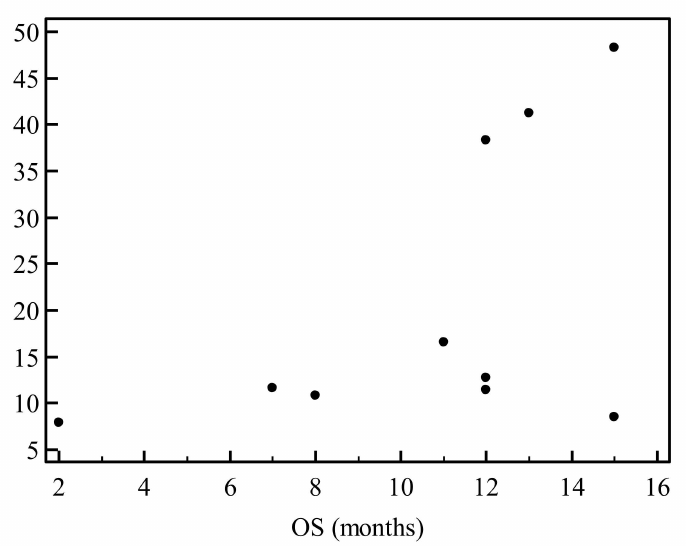
Figure 5. GATA6 / ZEB1 ratio shows a trend towards a correlation with overall survival of pancreatic cancer patients (Kendall’s Tau = 0.44, p = 0.08).